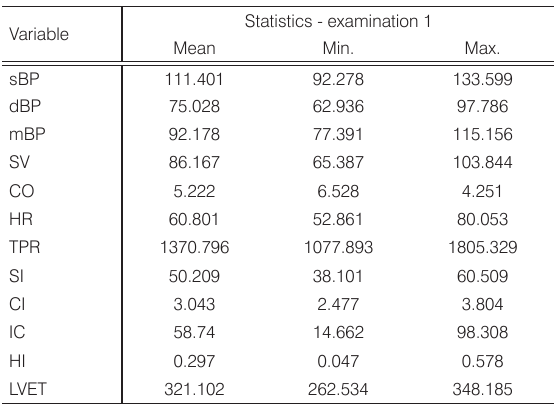
Table 5. Descriptive statistics of parameters: sBP, dBP, SV, CO, HR, SI, CI, IC, HI, LVET and TPR (Examination 1).